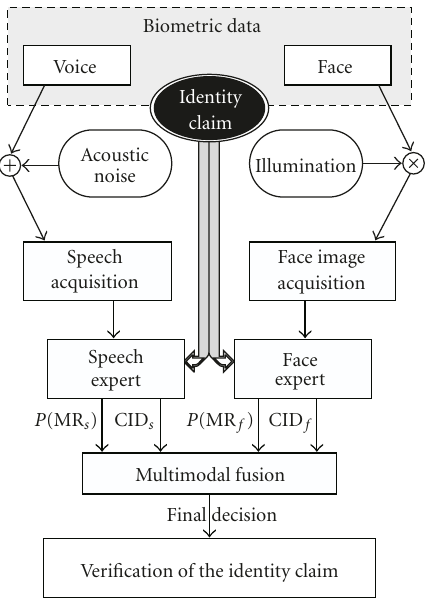
Figure 5: Multimodal biometric verification system with reliability information.